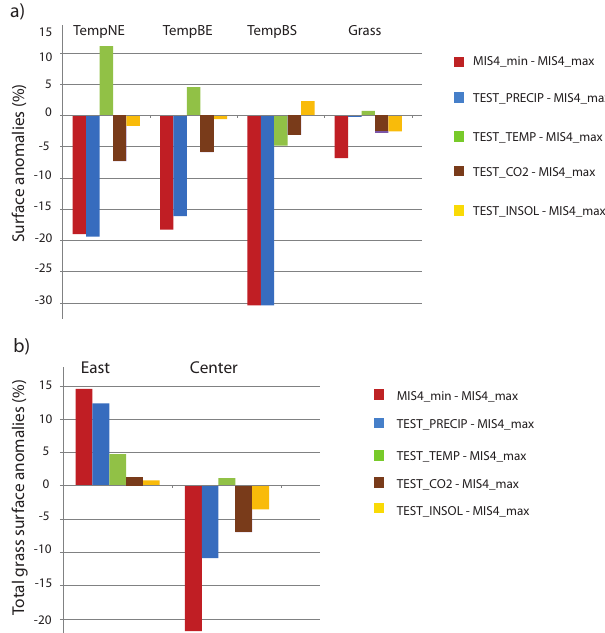
Figure 11. Percentage of changes in (a) the total surface oc- cupied by temperate needleleaved trees (TempNE), temperate broadleaved evergreen trees (TempBE), temperate broadleaved summergreen trees (TempBS) and grasses; (b) the total surface occupied by grasses in the east (34–25 ◦ S, 27–34 ◦ E) and in the center (33–25 ◦ S, 19–27 ◦ E) of southern Africa, in MIS4_min, TEST_PRECIP, TEST_TEMP, TEST_CO2 and TEST_INSOL compared to MIS4_max.